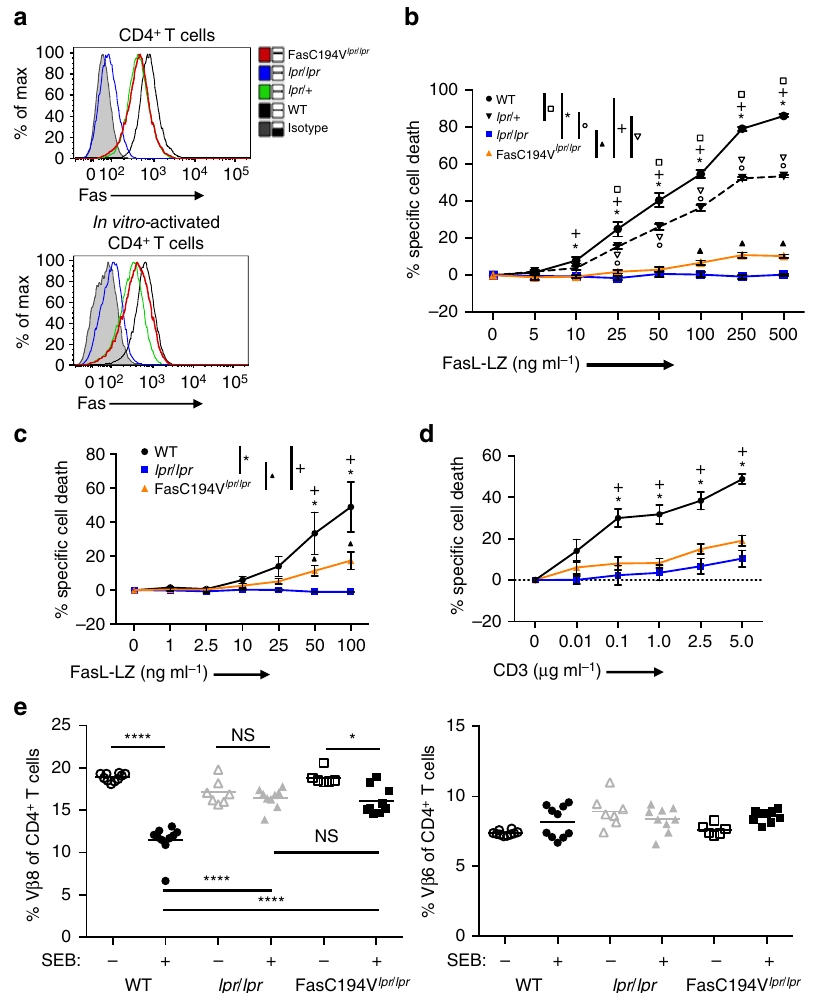
Figure 2 | Fas C194V is defective in inducing T-cell apoptosis. ( a ) Flow cytometry was performed on ex vivo resting and in vitro -activated and cultured CD4 þ Tcells of WT, lpr / þ , lpr/lpr or FasC194V lpr/lpr mice. Grey shaded: isotype control; Black: WT; Green: lpr / þ ; Blue: lpr/lpr ; Red Bold: FasC194V lpr/lpr . ( b ) In vitro -activated CD4 þ T cells from WT, lpr/ þ , lpr/lpr or FasC194V lpr/lpr mice were cultured in the presence of increasing amounts of FasL-LZ for 8 h before analysis for apoptosis by flow cytometry. Data are cumulative of six independent experiments and represents the mean specific cell death ± s.e.m. ( c ) Apoptosis of gated effector CD4 þ Tcells (TCR b þ B220 (cid:2) CD4 þ CD44 hi CD62L lo ) within lymphocytes from the spleen and lymph nodes of WT, lpr/lpr , or FasC194V lpr/lpr mice were stimulated with FasL-LZ and analysed as in b ( N ¼ 6). ( d ) In vitro -activated purified CD4 þ T cells from the indicated genotypes were stimulated with plate-bound anti-CD3 for 8 h before apoptosis analysis as in ( b ). Results are compiled from six independent experiments ( N ¼ 6) and represent the mean specific cells death ± s.e.m. ( e ) CD4 þ V b 8 þ T cells were analysed in 8–10-week-old WT, lpr/lpr ,